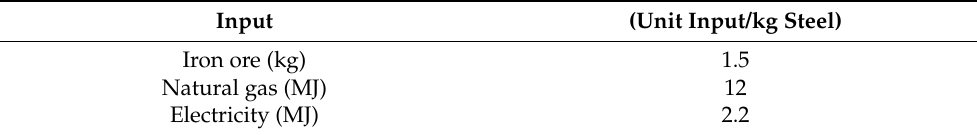
Table 4. Major inputs of natural gas-based DR plant and EAF.